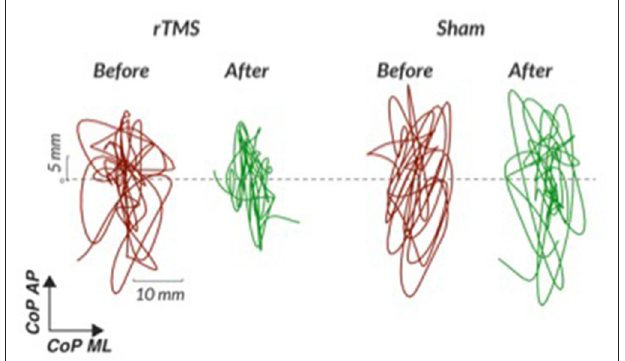
FIGURE 2 | Representative center of pressure sway excursions in quiet stance without movement of the force plate or surround (condition one of the Sensory Organization Test) before and after cerebellar repetitive TMS compared to sham TMS. rTMS, repetitive transcranial magnetic stimulation; CoP, center of pressure; AP, anterior-posterior; ML, medio-lateral; C1, condition